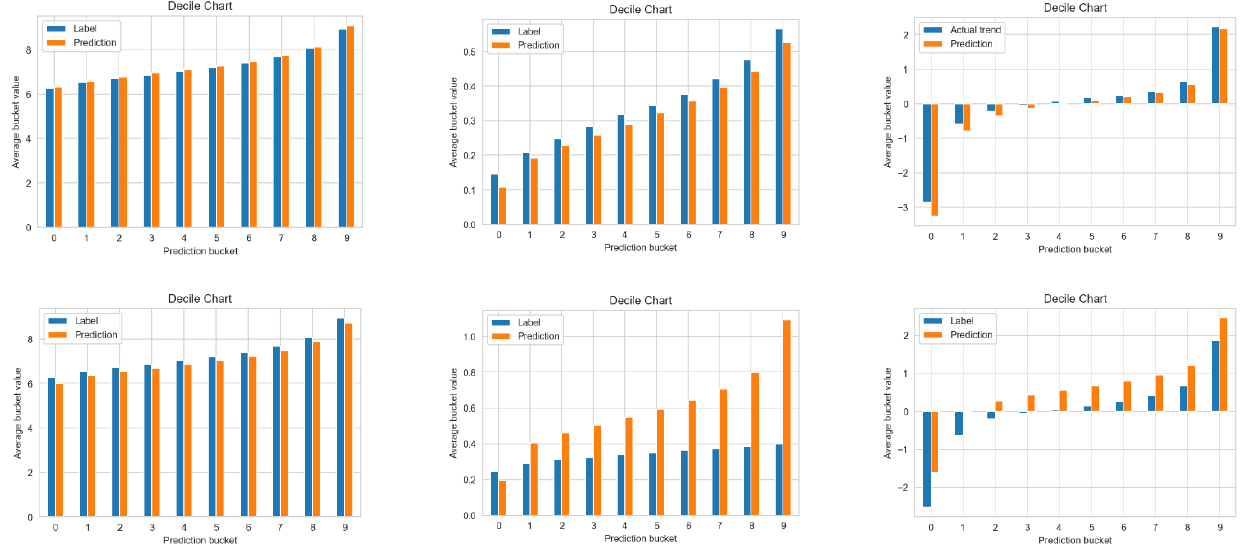
Figure 3. Decile charts for CLV, DPC, and TAS, respectively (top row: multi-output model, bottom row: single-output model result).